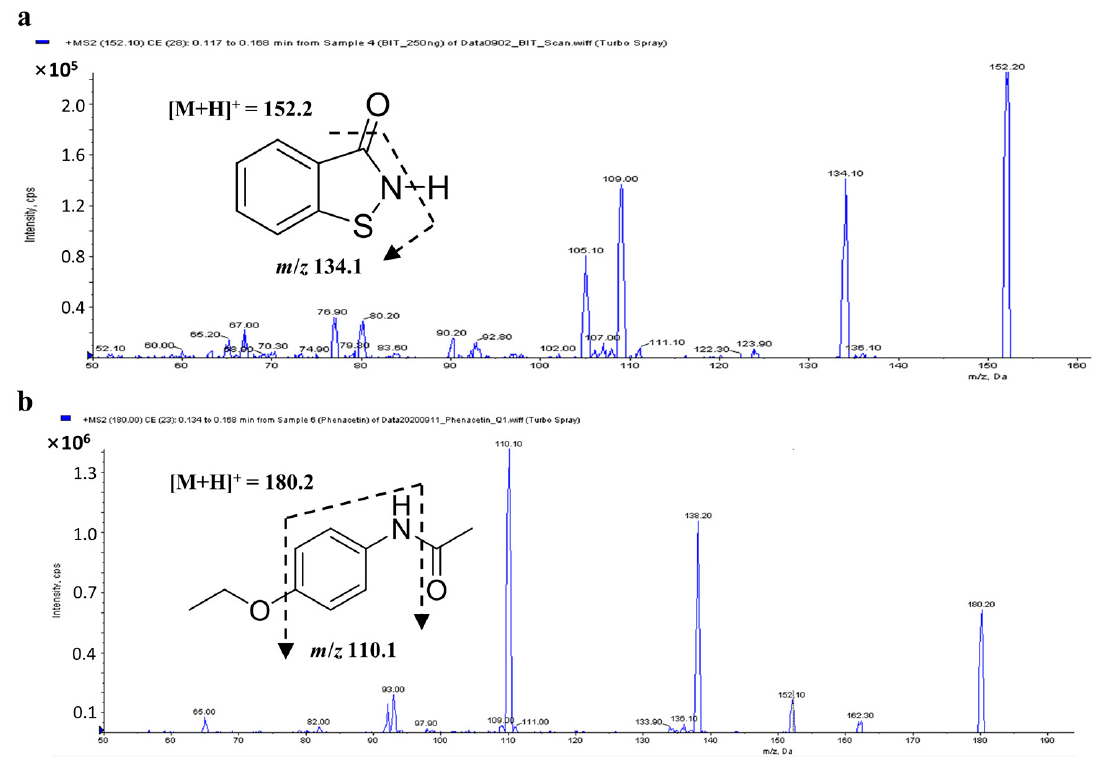
Figure 1. Chemical structures and product ion mass spectra of ( a ) benzisothiazolinone and ( b ) phenacetin, with [M + H] + at m / z 152.2 and 180.2 as the precursor ions.